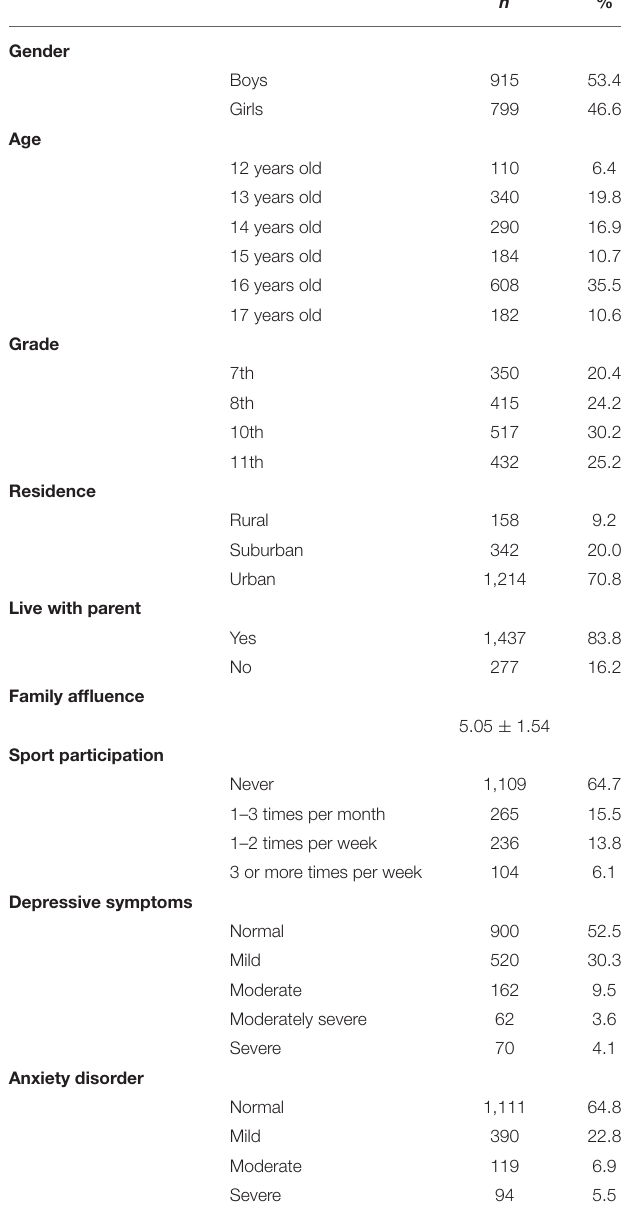
TABLE 1 | Sample characteristics of this